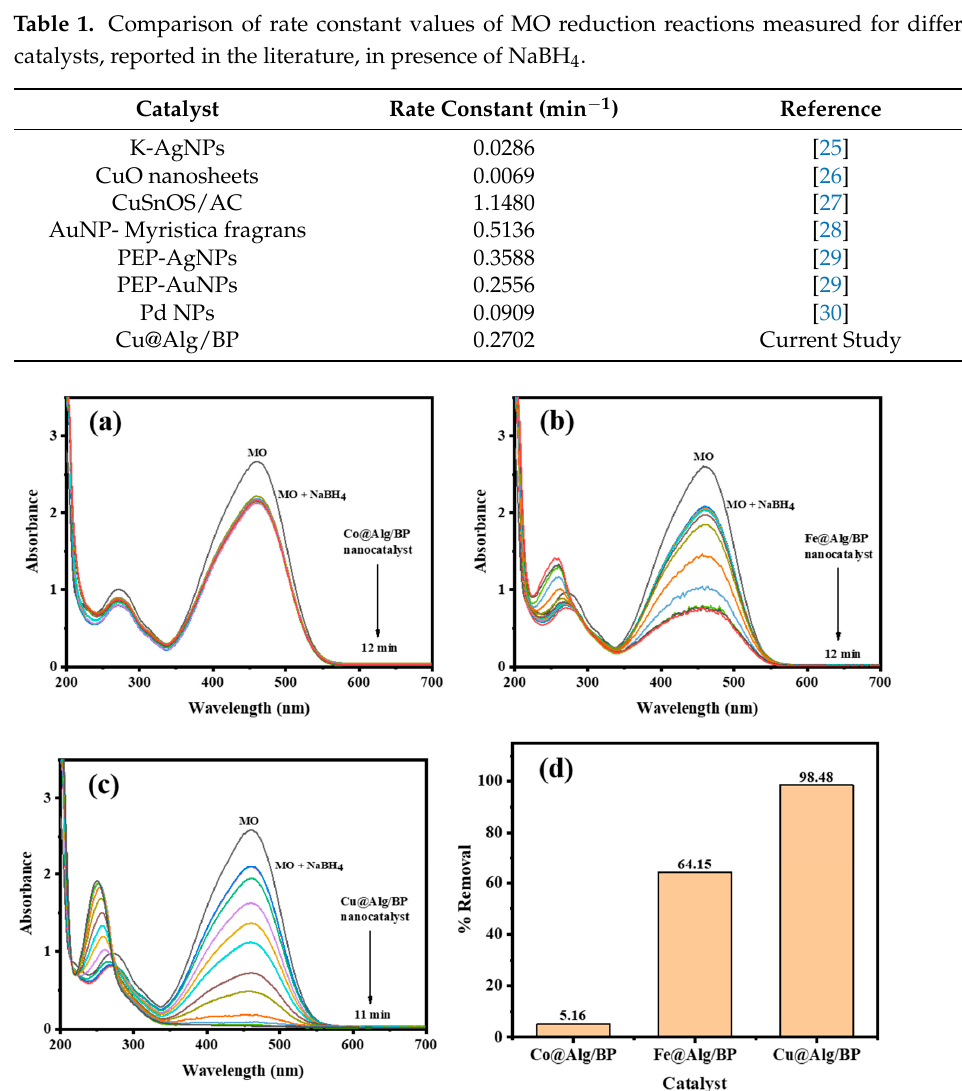
Figure 5. Time-dependent UV–vis spectra for MO reduction by NaBH 4 using 2 beads of ( a ) Co@Alg/BP; ( b ) Fe@Alg/BP; and ( c ) Cu@Alg/BP nanocatalysts. ( d ) Removal % of MO reduction using